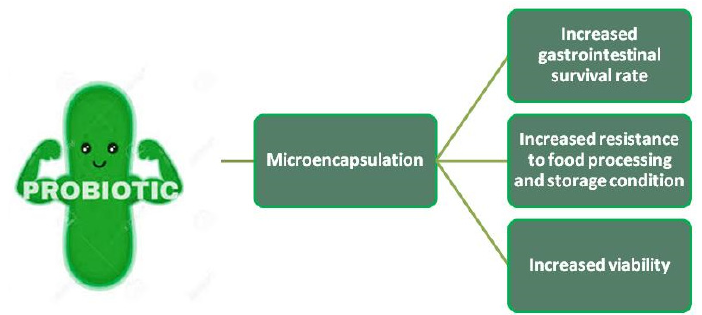
Figure 2. Role of microencapsulation on probiotic microorganisms.